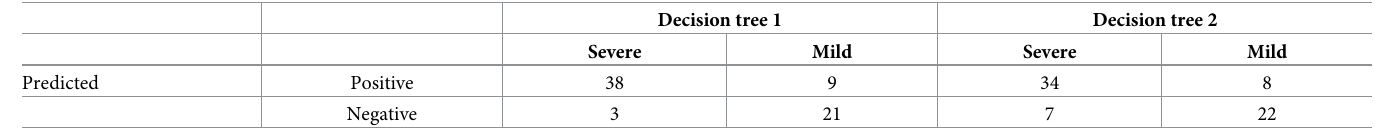
Fig 3. Decision tree based on demographic and clinical characteristics of SFTS patients. Limb.tre = limb tremor; 1 = ‘YES’, 0 = ‘NO’. https://doi.org/10.1371/journal.pone.0255033.g003 The confusion matrices of the two decision trees are summarized in Table 3. The sensitivity, specificity, accuracy and Youden’s index of the two decision trees are displayed in Table 4. The decision tree based on the laboratory parameters of SFTS patients achieved a sensitivity of 92.7% and a specificity of 70.0%. The sensitivity and specificity of the decision tree based on Table 3. Confusion matrices of the two decision